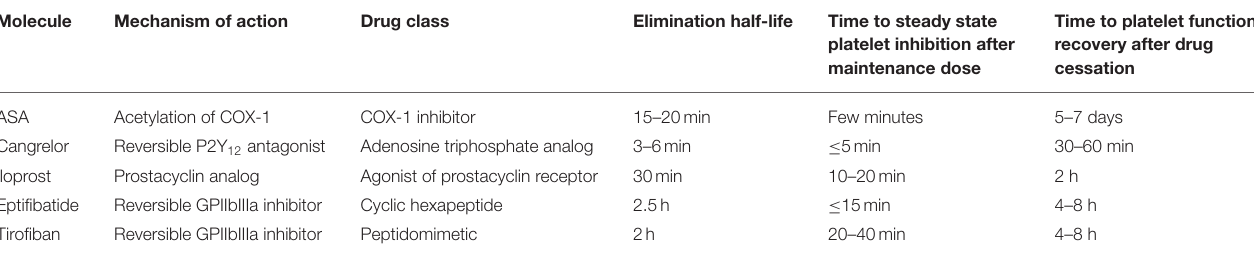
TABLE 2 | Pharmacological characteristics of intravenous antiplatelet drugs (11, 13, 15, 19–23).